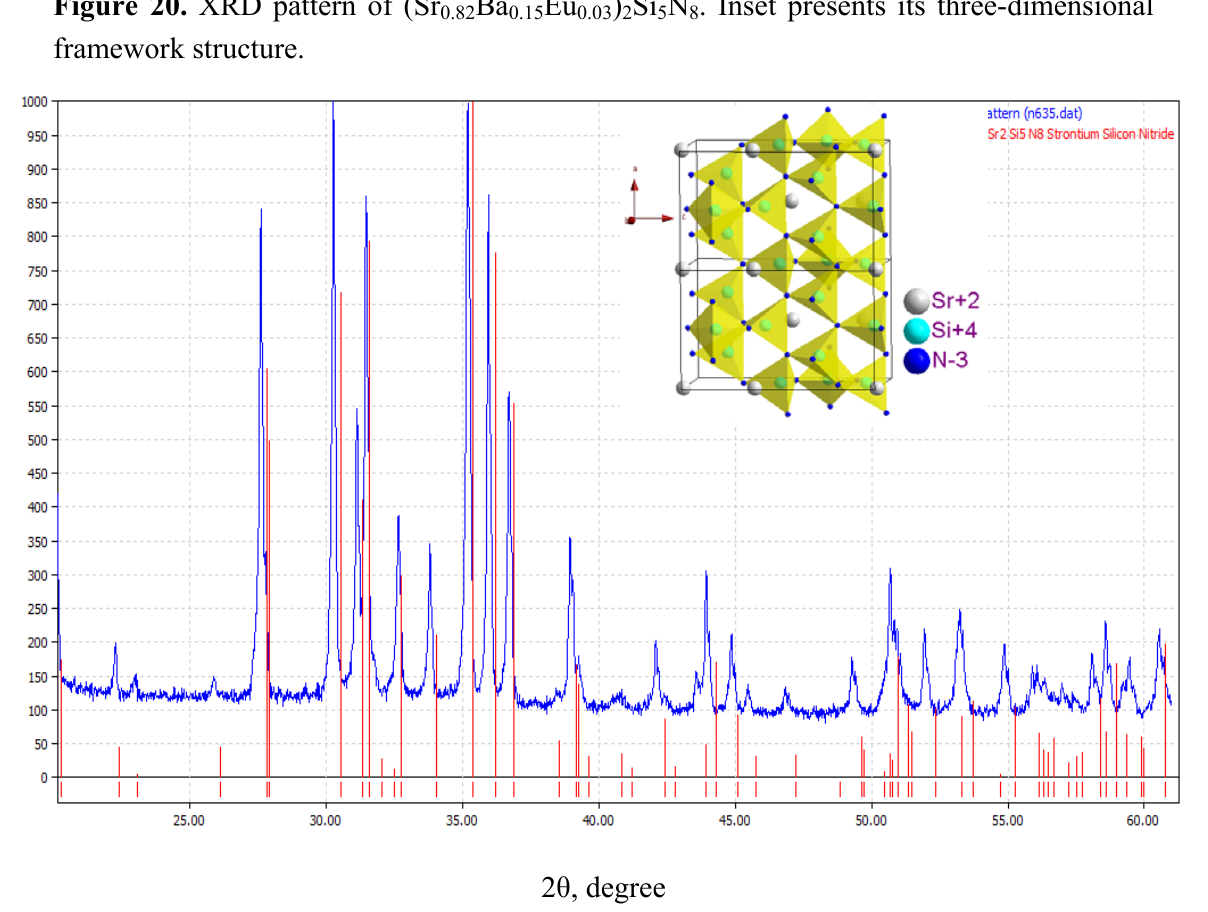
Figure 20. XRD pattern of (Sr